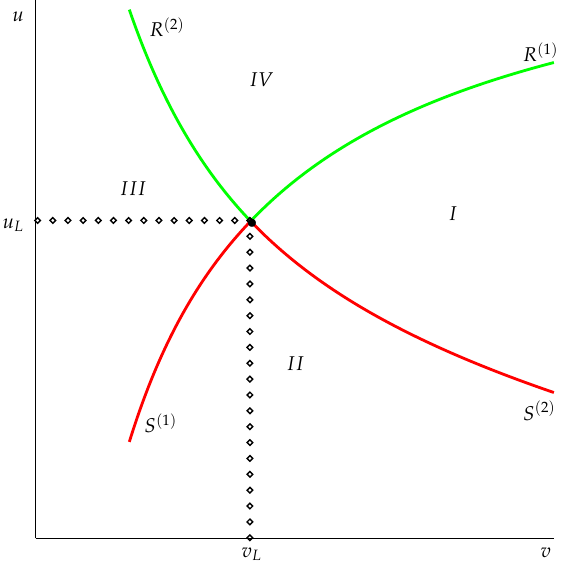
Figure 1. Generalised rarefaction curves and shock curves passing through ( v L , u L ) in the ( v , u ) plane. In red, the shock curves S ( 1,2 ) given, respectively by (60) and (61). In green, the generalised rarefaction curves R ( 1,2 ) characterised by (51) and